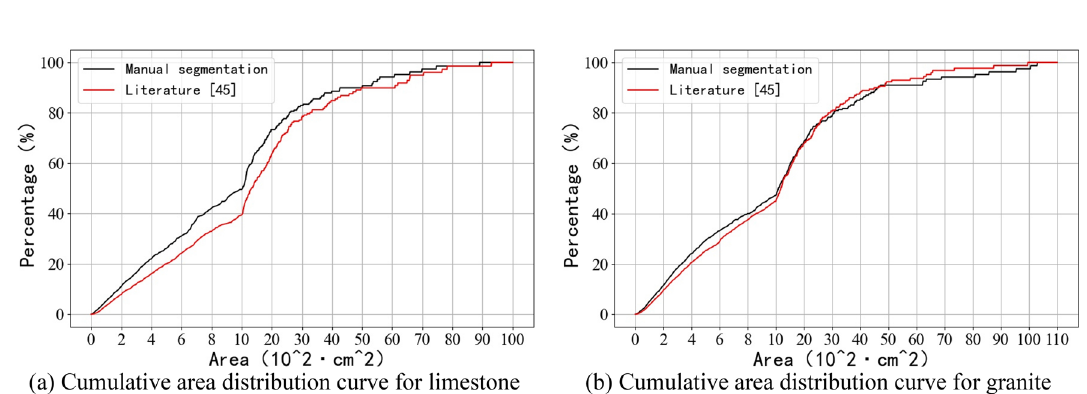
Figure 23. The cumulative area distribution curve for segmentation results in the literature 45